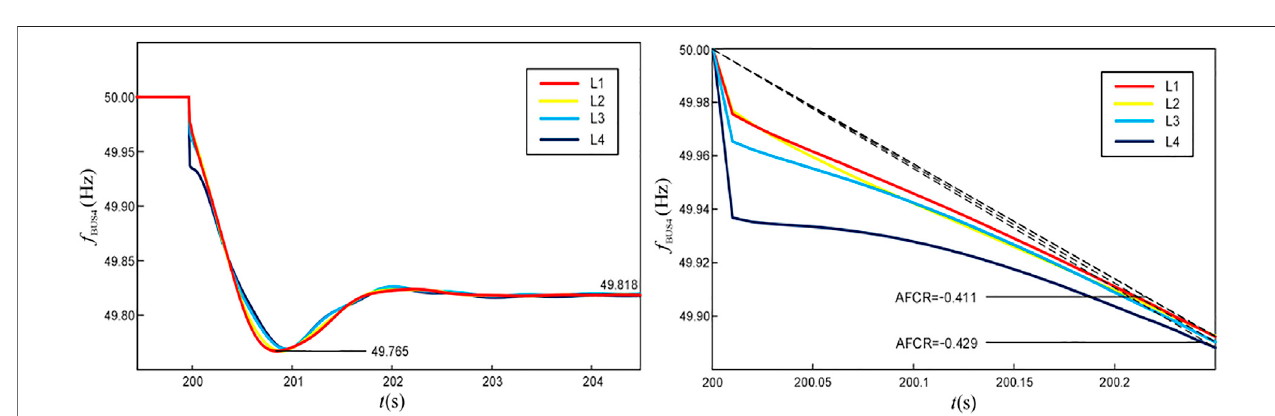
FIGURE 5 | Frequency response of the system at Bus 4.